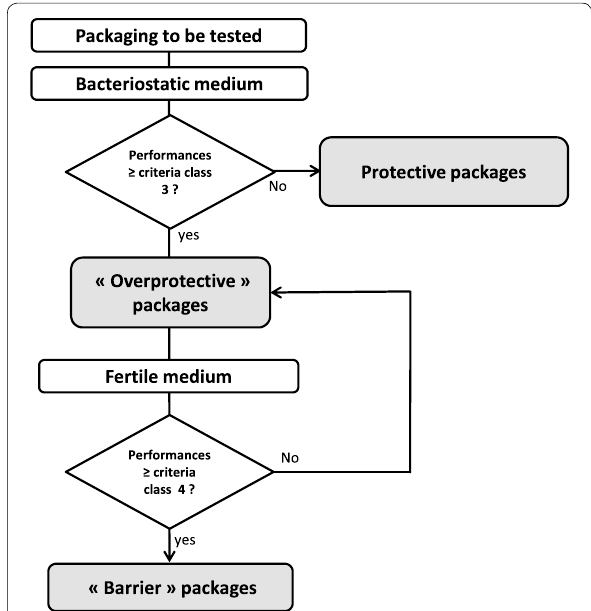
Fig. 4 Flowchart established to classify the microbial protection potential of